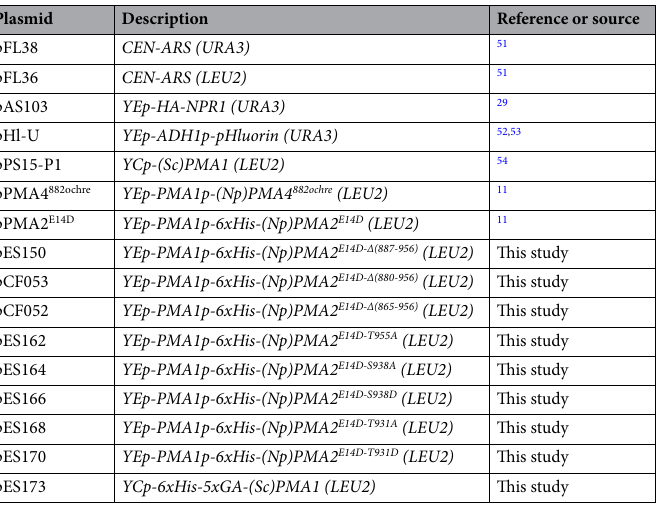
Table 1. Plasmids used in this